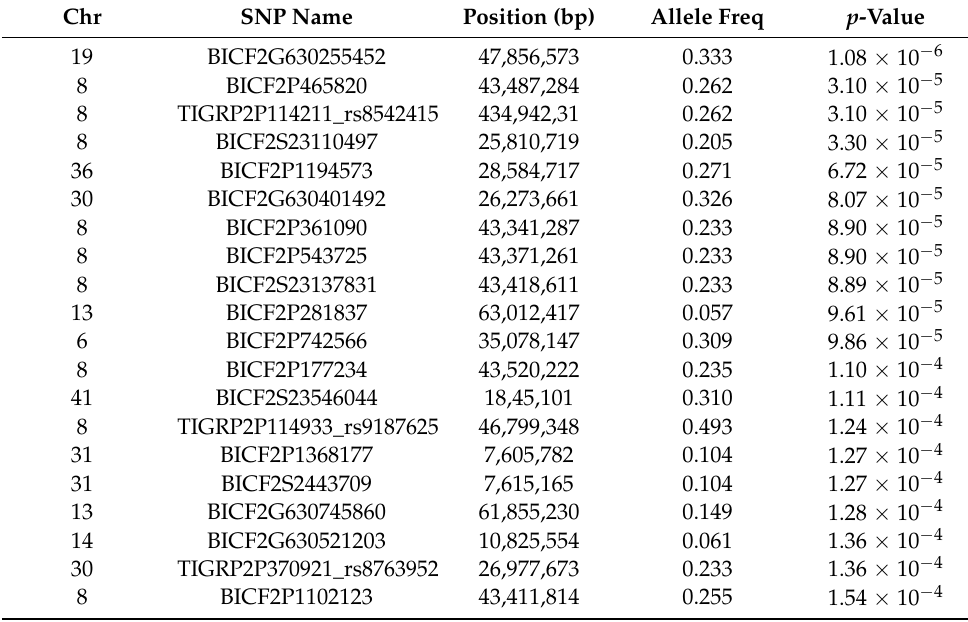
Table 1. Case/control GWAS results showing chromosome (Chr), SNP name, position (bp), allele fre- quency, and raw p -value for the top twenty SNPs. One significant SNP was identified on chromosome 19. The interrupted line represents the Bonferroni cut-off.